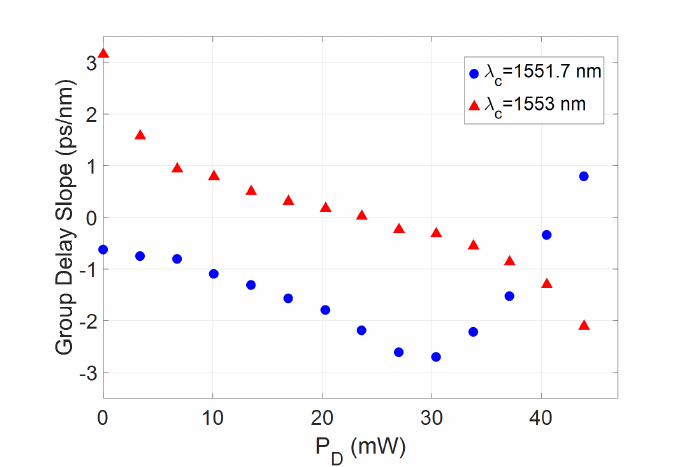
Figure 10. Measured group delay slope as a function of dissipated power on the heater corresponding to the dispersion bands centred at 1551.7nm; and